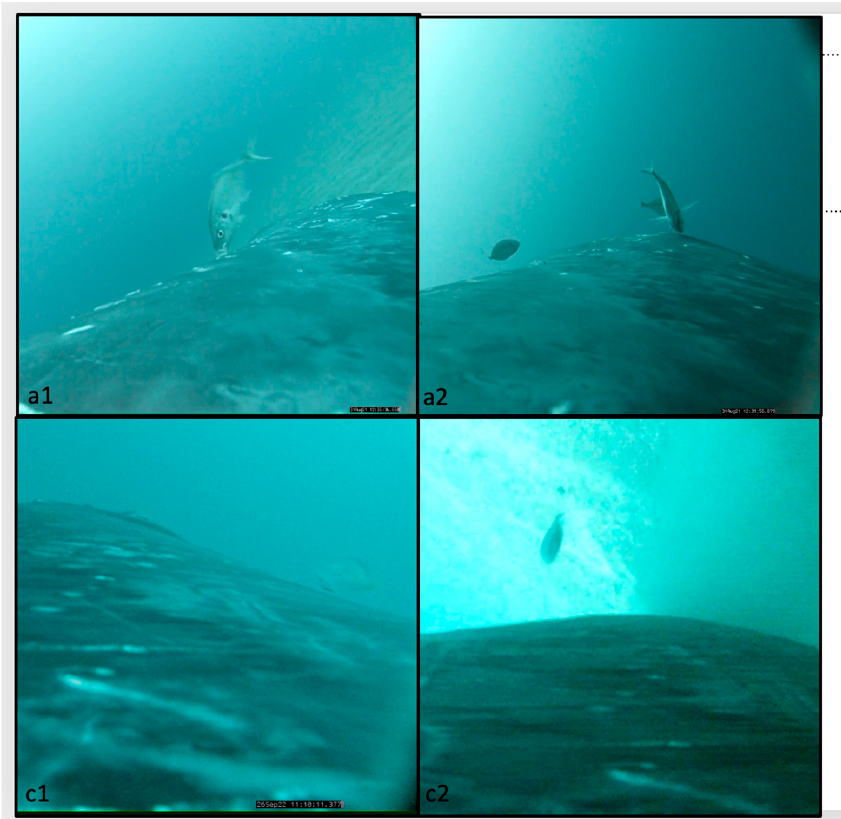
Figure 3. Silver trevally ( Pseudocaranx georgianus ) observed near the whale when rolling in the sand for tag a and c. Screen shots from the video from tag a show the fish actively feeding off the whales’ skin and from tag c some of the fish were seen swimming close the whale. Sand rolling of the tagged individual and of at least one accompanying whale that can be seen rolling at the same time took place 107 min after deployment. A half roll